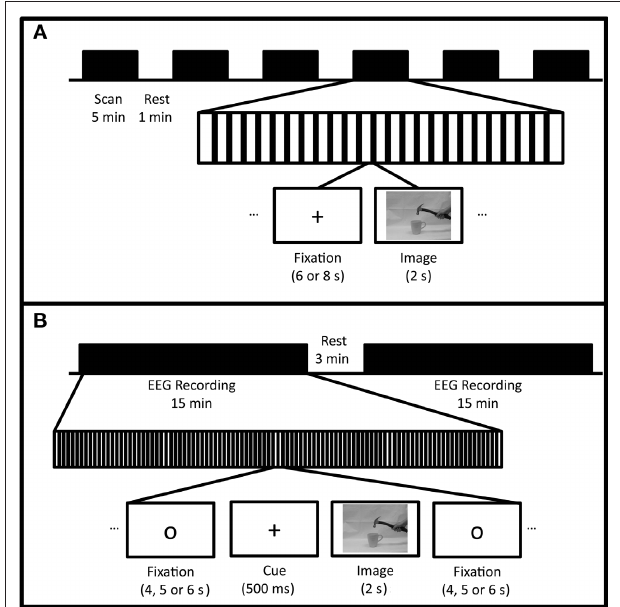
FIGuRE 1 | (A) Experimental design for fMRI sessions. Six runs of functional scans were conducted with approximately 1 min of rest between each. Within each run, 24 images were presented (eight correct, eight incorrect, and eight tool-only) with a 2-s duration. Fixation crosses (6 or 8 s duration) were presented between images. (B) Experimental design for EEG sessions. Within each of two blocks of recording, 75 images were presented (25 correct, 25 incorrect, 25 tool-only). Each image was preceded by a fixation circle (4–6 s duration) and alerting cue (500 ms